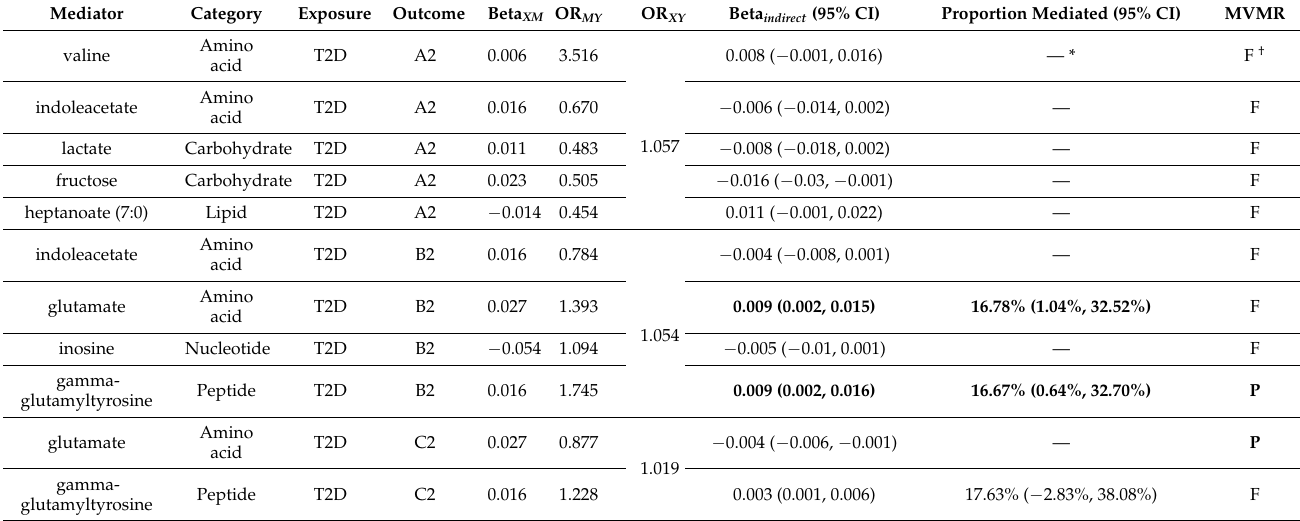
Table 2. Mediation effects of human serum metabolites in the total effect between T2D and COVID-19